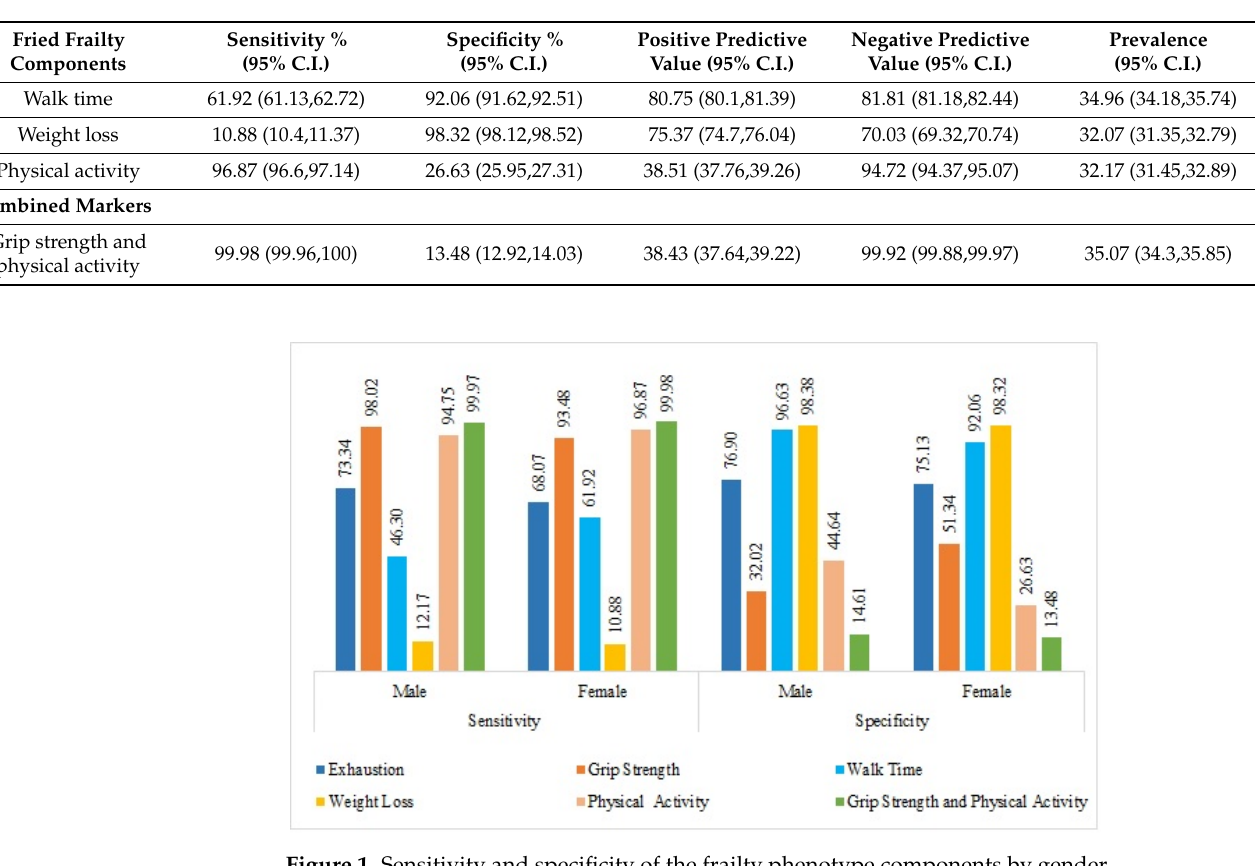
Figure 1. Sensitivity and specificity of the frailty phenotype components by gender.